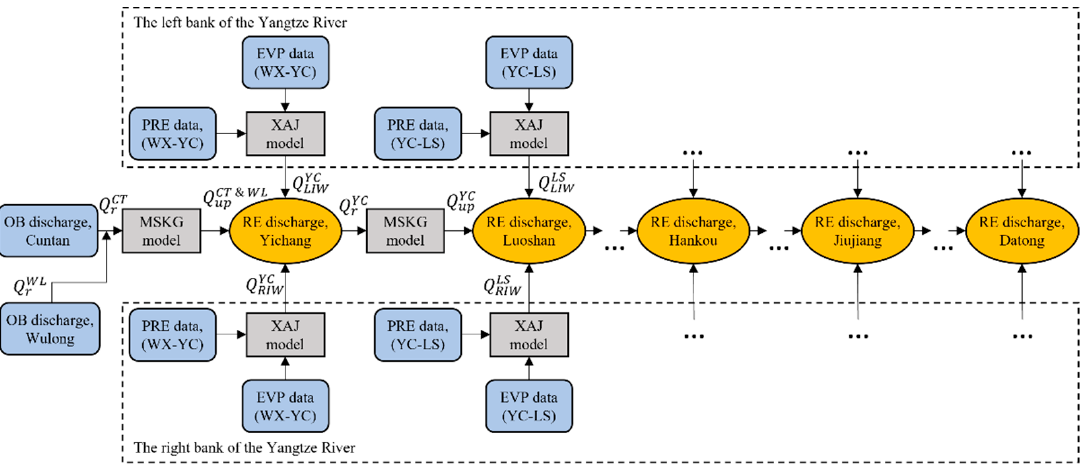
Figure 2. Flowchart of reconstructed discharge modeling in the downstream from the TGD. CT: Cuntan, WL: Wulong, YC: Yichang, LS: Luoshan, HK: Hankou, JJ: Jiujiang, DT: Datong, OB: observed, RE: reconstructed, XAJ model: Xin’anjiang model; MSKG model: Muskingum routing model.